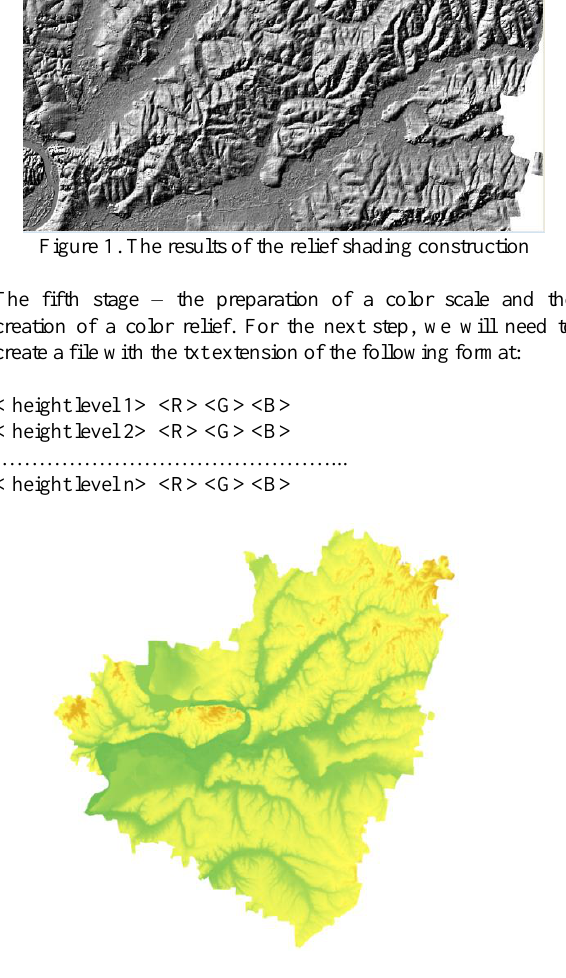
Figure 2. The results of the colorized relief